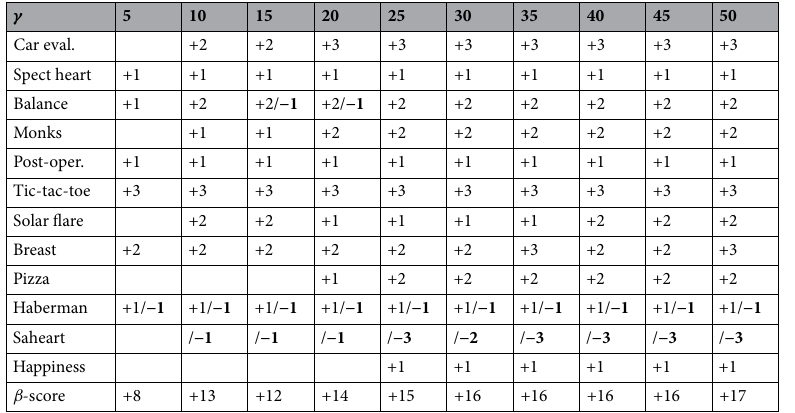
c + c − . The numbers in the